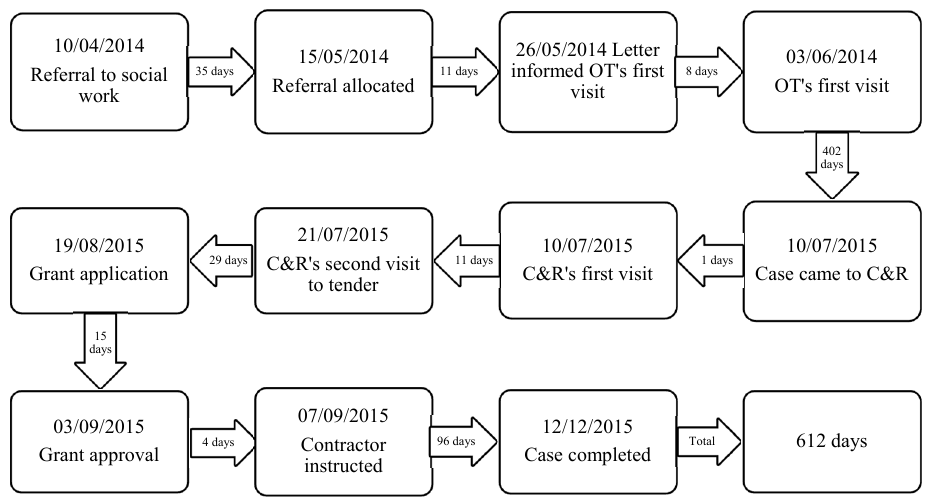
Figure 2. The timeline of the adaptation process for Client B.